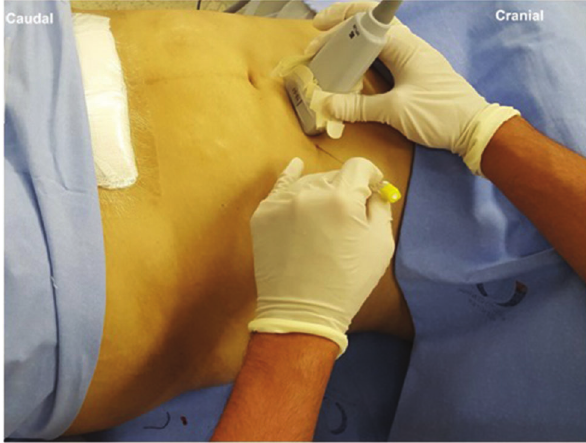
Figure 8 - Probe and needle position for performing RAS